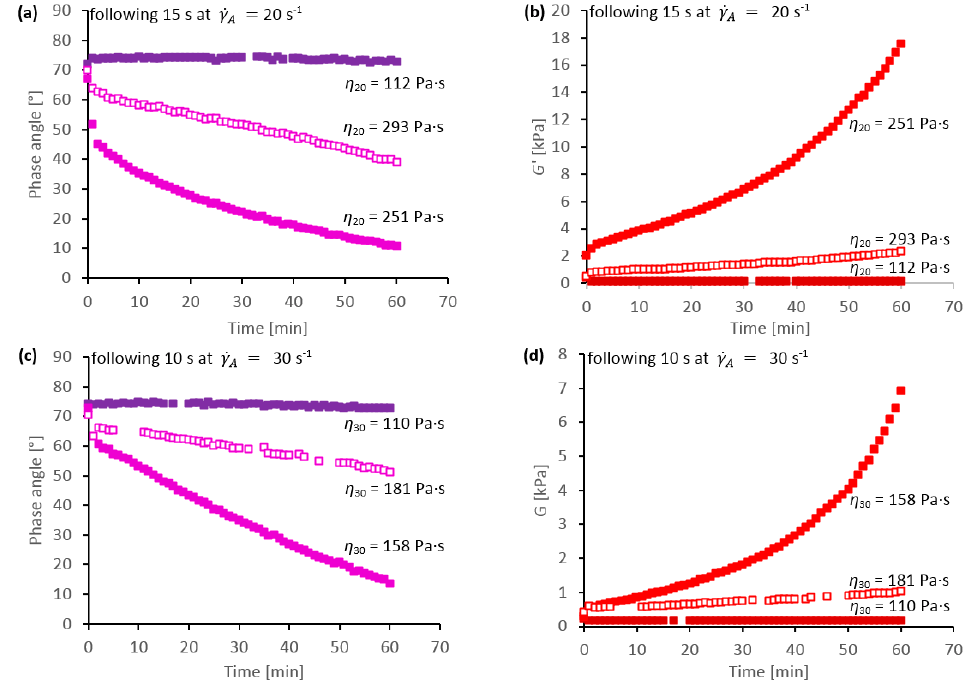
Figure 3. Examples of rheological behaviour for different feedstock specimens, following (successful or unsuccessful) attempts at flow-initiated phase changes: plots of ( a ) phase angle and ( b ) elastic modulus at 0.2 Hz vs. time, following 15 s period of flow at a shear rate of 20 s − 1 ; ( c , d ) corresponding data following 10 s flow at 30 s − 1 . The viscosities quoted for each specimen were determined at the end of the period of initiation flow, at the shear rate shown.